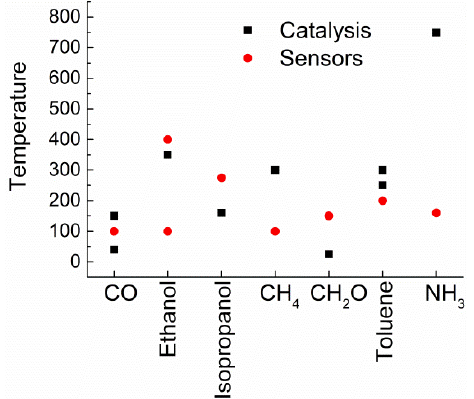
Figure 1. Best operating temperatures for the indicated sensing (best operating temperature and response tradeoff) and oxidation (lowest total combustion temperature) experiments over Co 3 O 4 materials. More points are present when appreciable spread of the results was found. The references are reported in the discussion.